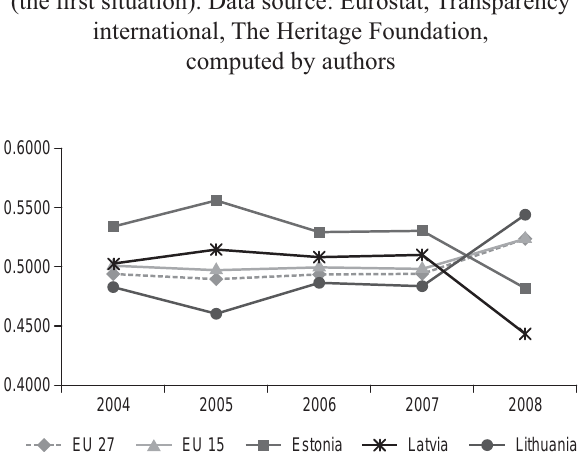
Fig. 2. Dynamics of aggregated assessment of Baltic countries in the EU context during the period of 2004–2008 (the fi rst situation). Data source: Eurostat, Transparency international, The